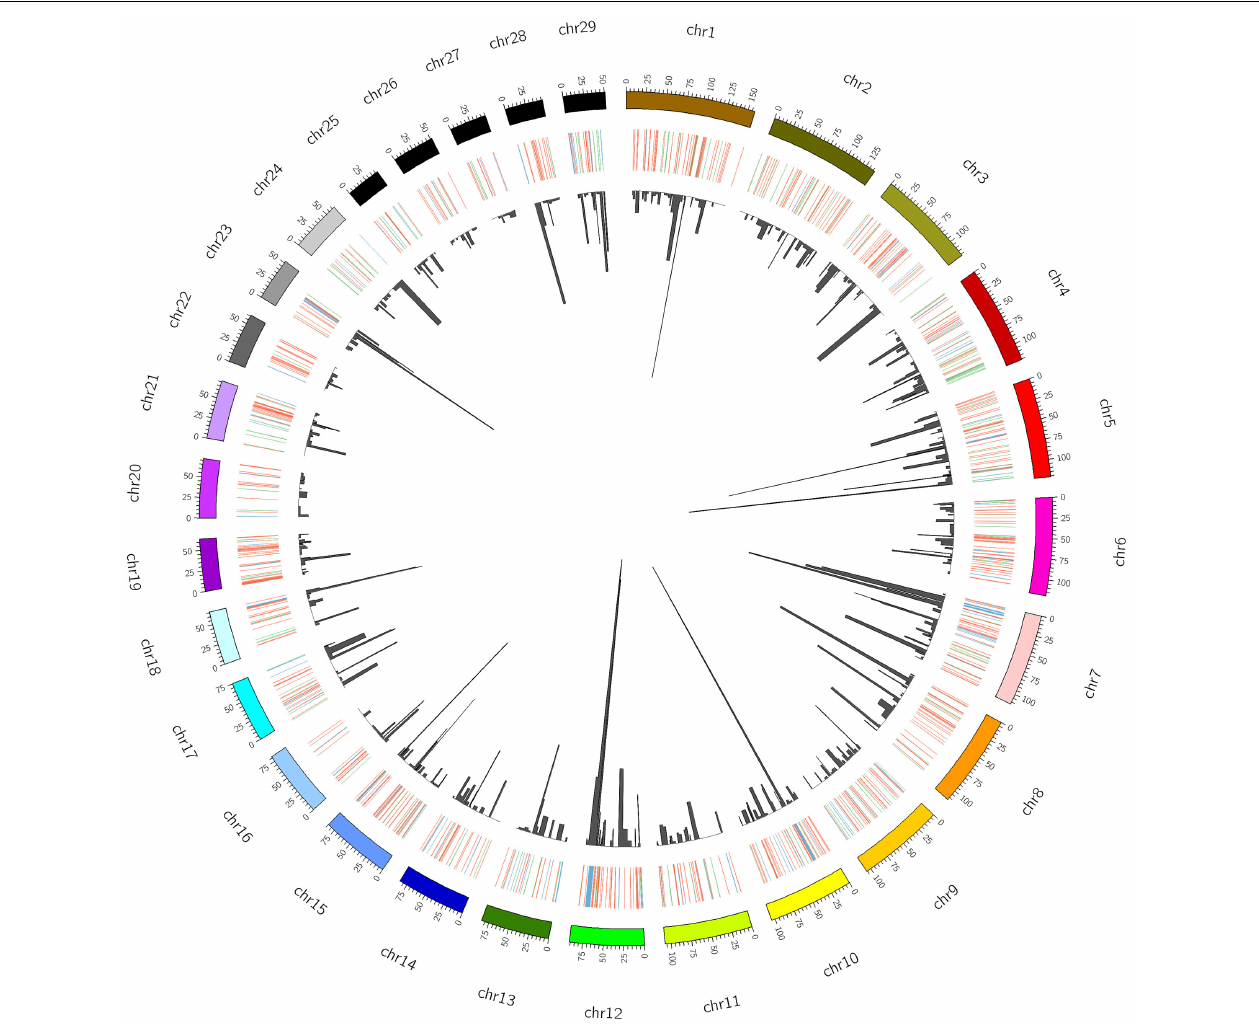
FIGURE 2 | Distribution, status and frequency of CNVR in the bovine genome (UMD 3.1). The status of CNVRs are shown in outer circle in Red (loss), Green (gain) and Blue (both), while the inner circle is indicative of the